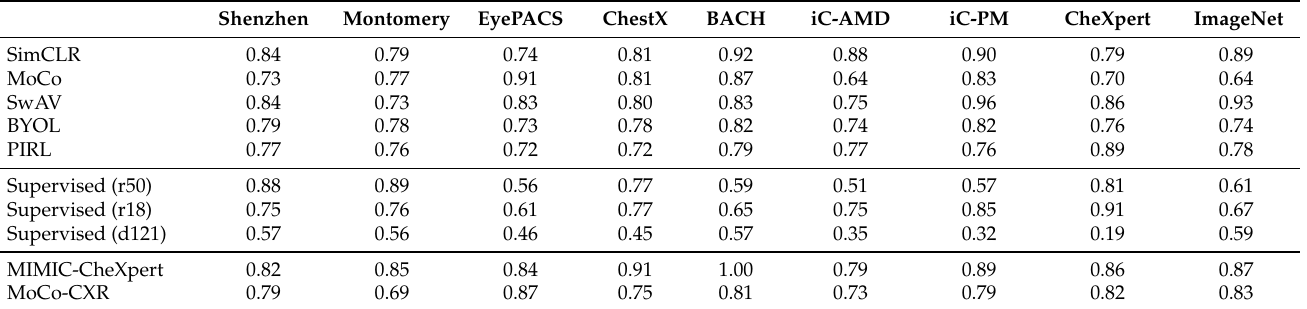
Table A6. Perceptual distance values, as measured by the LPIPS (Learned Perceptual Image Patch Similarity) metric using the VGG architecture, for the reconstructed images for each model for each dataset. A low value close to 0 indicates a strong perceptual similarity between the original and reconstructed images.